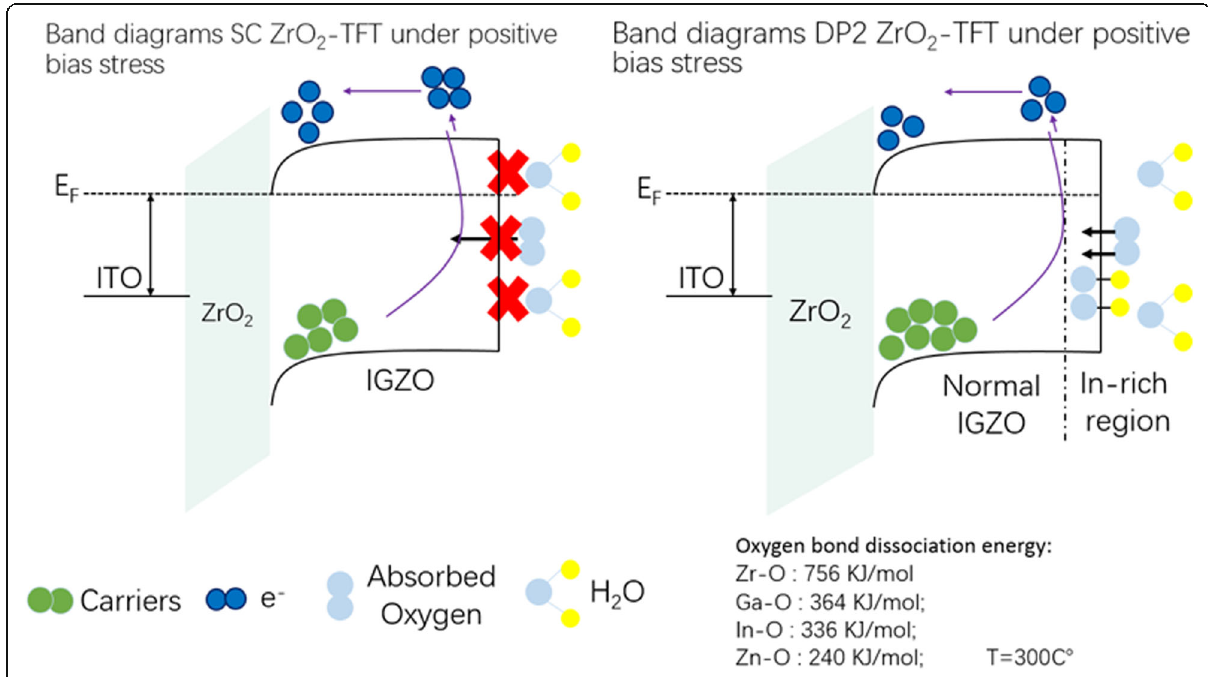
Fig. 7 Band diagrams SC-ZrO 2 TFT and DP2-ZrO 2 TFT under positive bias